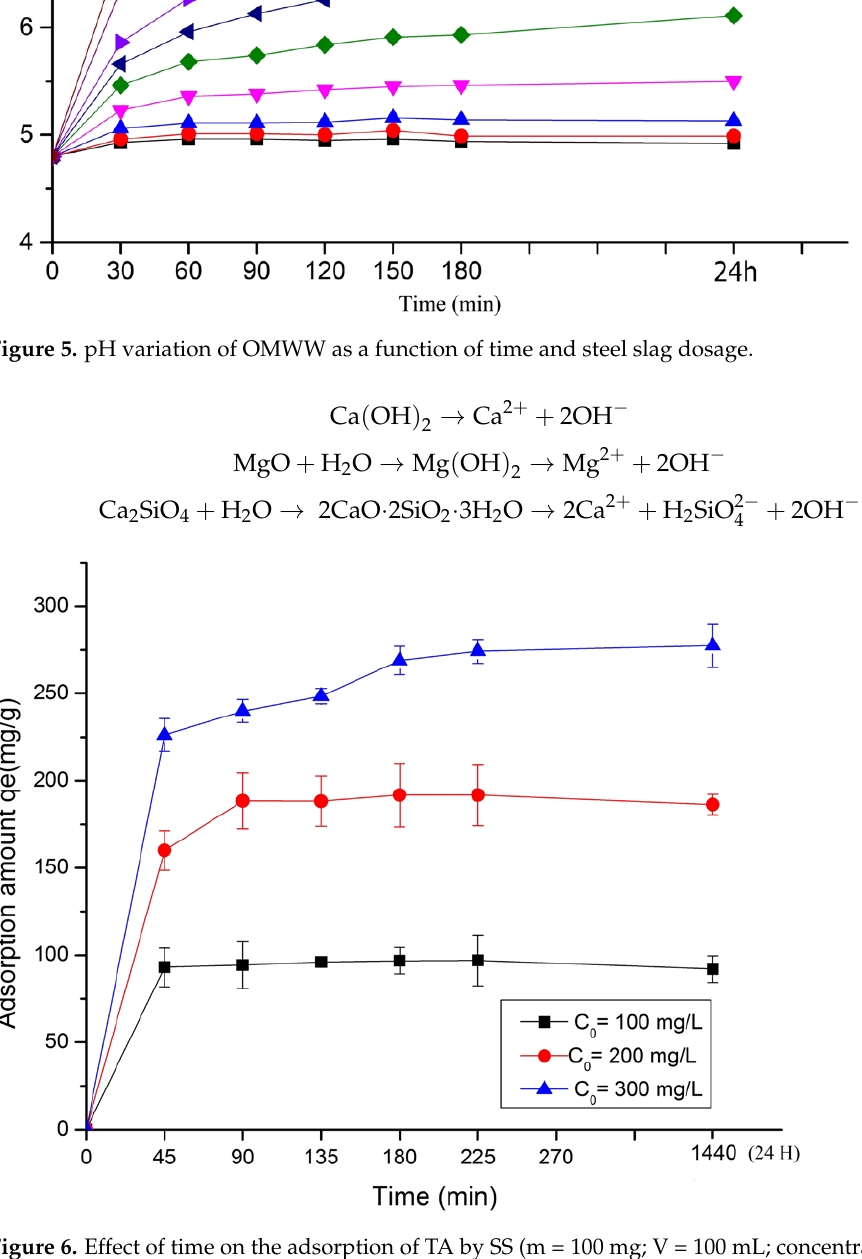
Figure 6. Effect of time on the adsorption of TA by SS (m = 100 mg; V = 100 mL; concentration = 100, 200 and 300 mg/L; pH = 5.8 ± 0.1; T = 293 ± 1 K; Agitation = 500 rpm). Murdiati et al. reported that the reaction between TA and Ca(OH) 2 generates binded insoluble complexes [69]. Other authors added that complexation through chelation is possible between calcium and TA [70]. In comparison, other authors confirmed that the presence of Ca 2+ in the solution greatly enhanced the adsorption of TA on polystyrene microplastics. In another study, Murdiati et al. studied the capacity of polyvinylpyroli- done (PVP), Ca(OH) 2 , and activated charcoal to precipitate TA in solution and found that Ca(OH) 2 was more effective in the precipitation process of tannin and tannic acid [71]. This explains the fast adsorption of low TA concentration by SS, and may suggest that the formation of SS–TA complex depends on the initial TA concentration and the accessible free cations and hydroxyl groups in the solution. However, the adsorption of TA onto accessible mesopores should not be ignored.